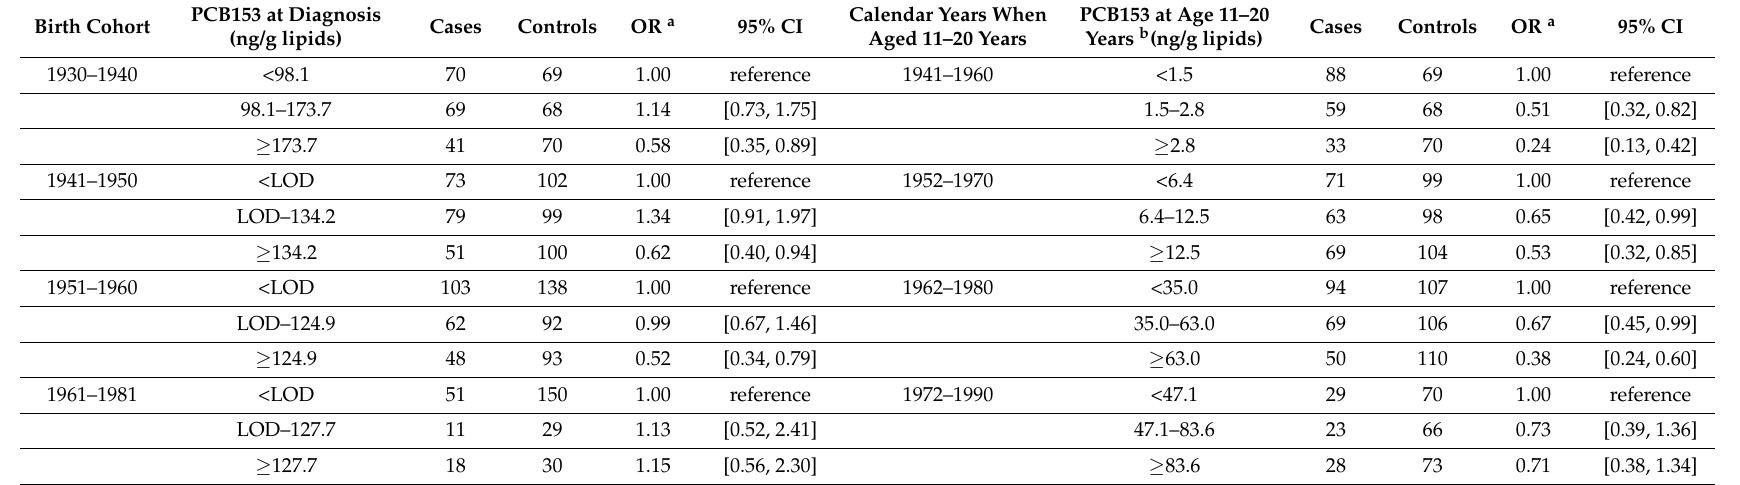
Table 4. Associations between breast cancer and PCB153 circulating levels measured at the date of diagnosis for the cases and the matched controls or PBPK-derived estimates of PCB153 concentrations at age 11–20 years, stratified by birth